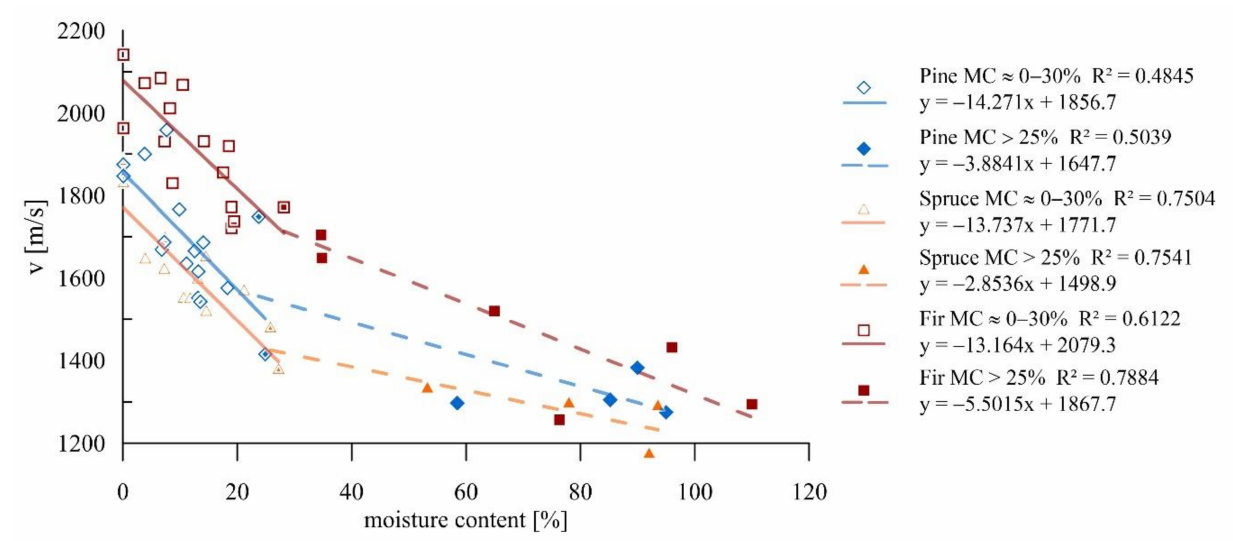
Figure 10. Ultrasonic wave testing for samples of different moisture